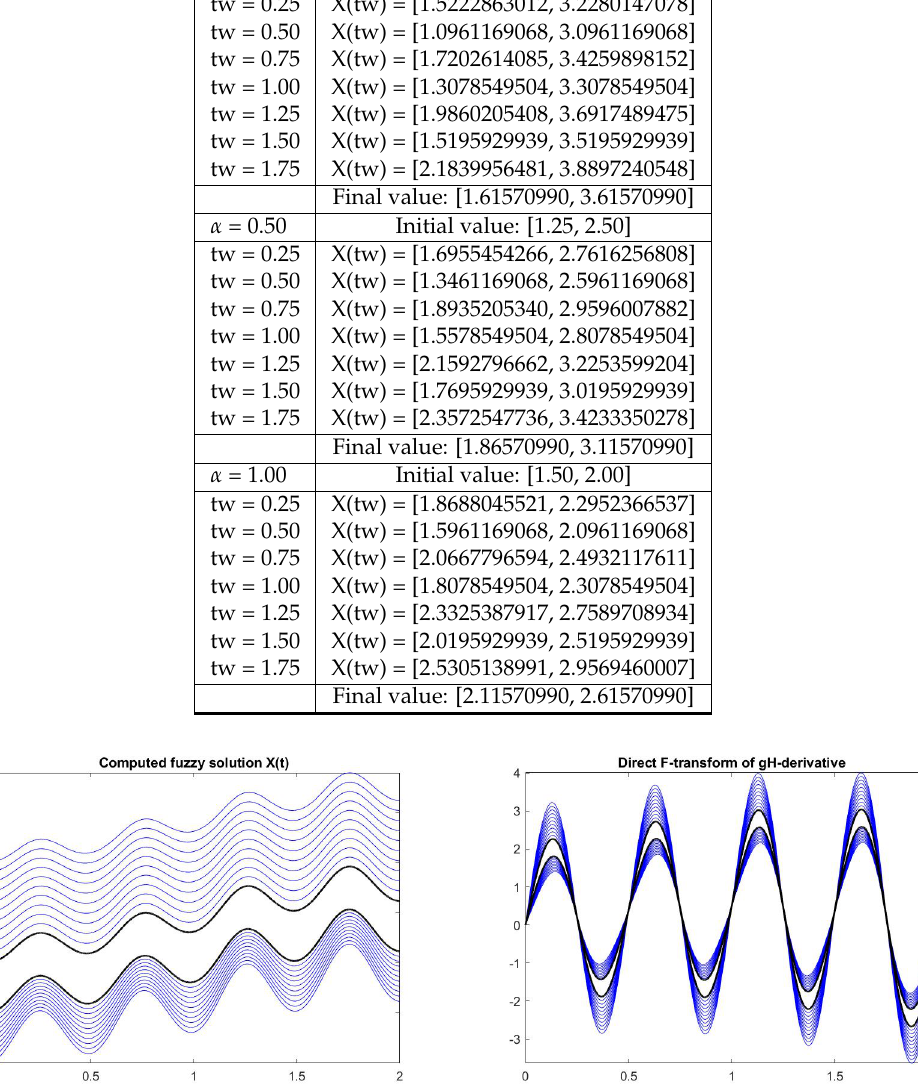
Table 2. (Interval-valued problem IDE1-b): For three values of α ∈ { 0,0.5,1 } , the seven switching points tw corresponding to Meth=2 are given in the first column; the second column contains the interval-valued solution X ( tw ) = [ x − α ( tw ) , x + α ( tw )] . α = 0.00